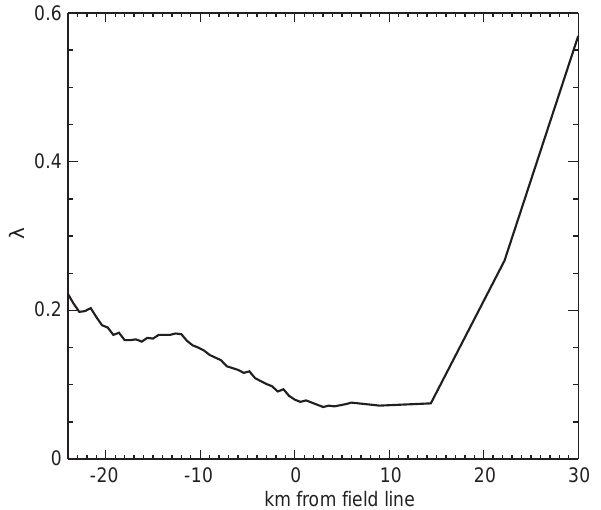
Fig. 5. Quality parameter (cid:107) for the arc reconstruction from the Norway images for the time-period 1836:00–1838:30 UT on 30 January 1995 when the arc moved from north (positive distances between the arc center and the radar beam) to south through the EISCAT